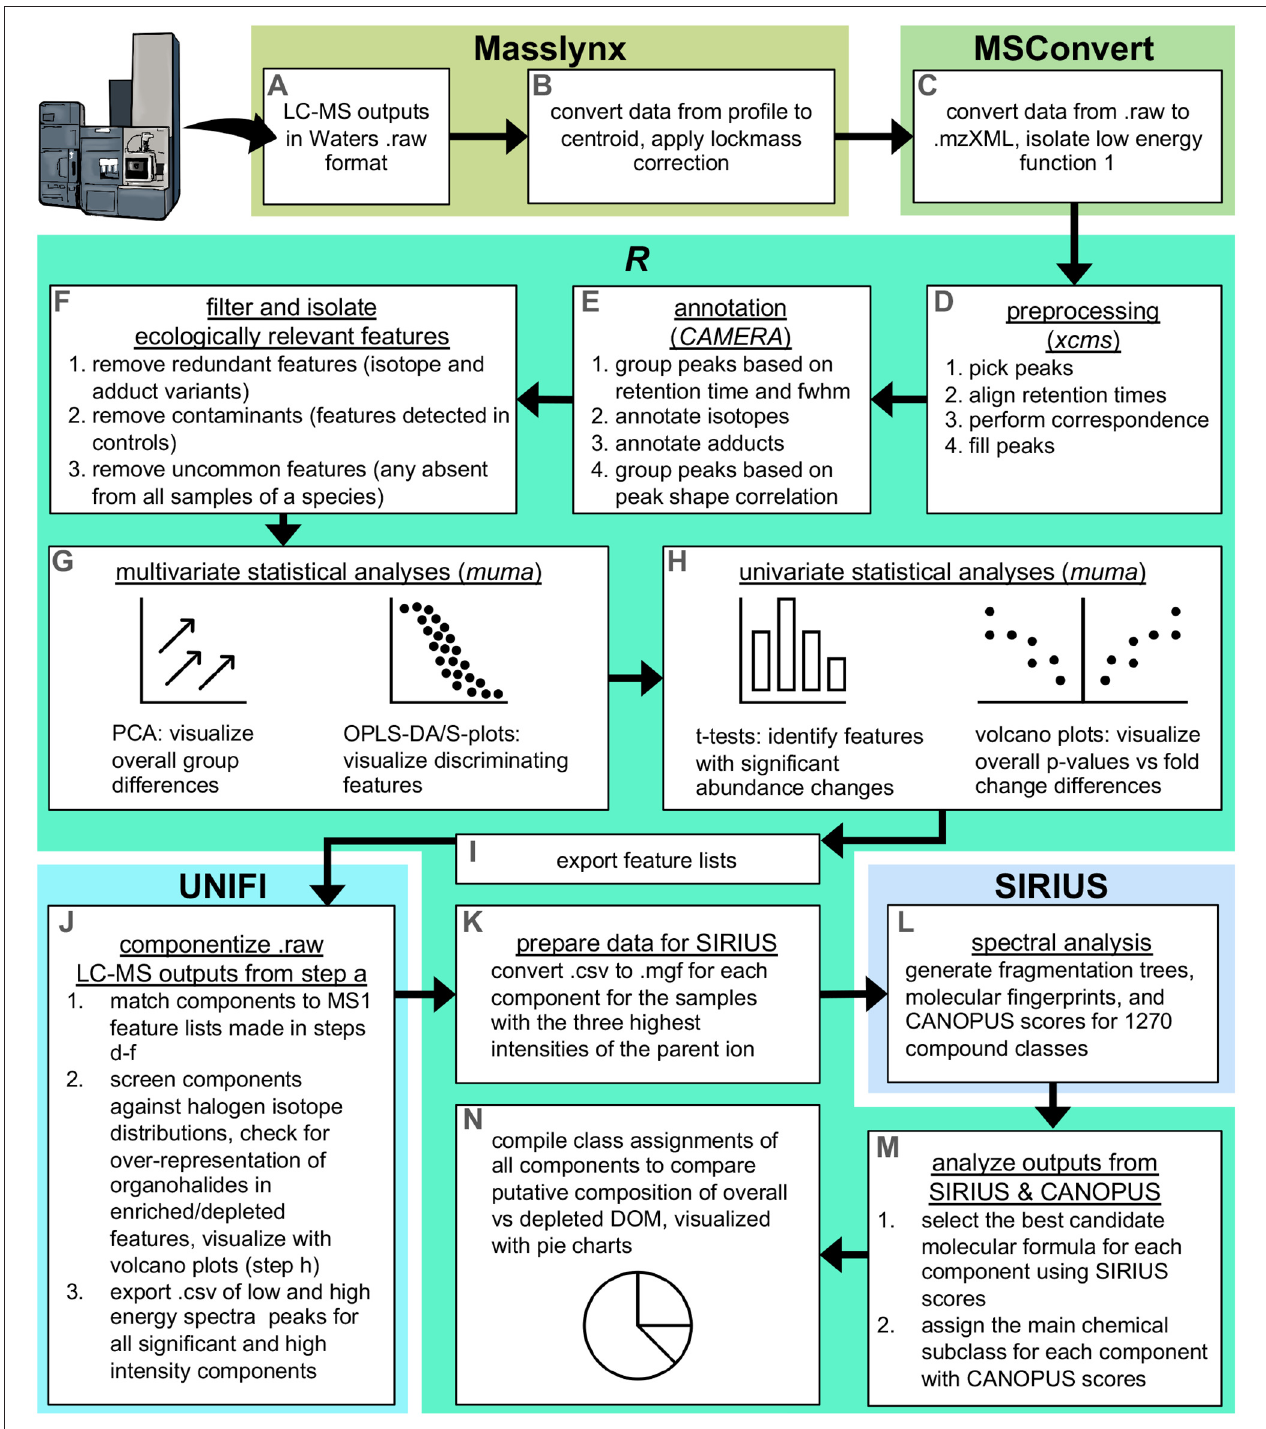
FIGURE 1 | Summary of the data analysis workflow. The process started in Masslynx, where (A) . Raw LC-MS outputs were (B) centroided and subsequently (C) converted to .mzXML in MSconvert (Chambers et al., 2012), and then (D–H) processed and statistically analyzed in R using XCMS , CAMERA , and muma (Smith et al., 2006; Kuhl et al., 2012; Gaude et al., 2013). Feature lists were then (I) exported to use as targets for (J) componentization in UNIFI. This produced fragmentation peaks that were (K) converted in R to be compatible for (L) spectral analysis in SIRIUS using the CANOPUS submodule (Böcker et al., 2009; Dührkop et al., 2015, 2019, 2020; Böcker and Dührkop, 2016; Djoumbou Feunang et al., 2016), followed by (M,N) analysis of SIRIUS/CANOPUS outputs in